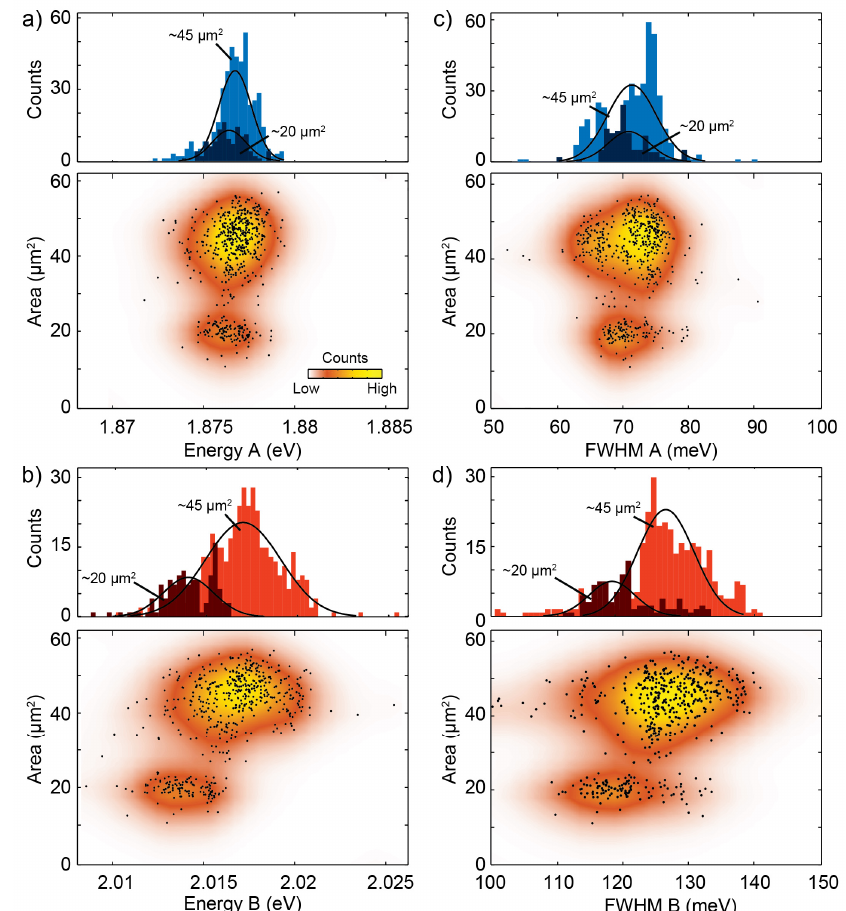
Figure 5. ( a ) Density plot of the triangle orientation as a function of the A exciton energy. (top) Conditional histograms of the A exciton energy for triangles with area between 15 μ m 2 and 25 μ m 2 (light blue) and triangles with area between 35 μ m 2 and 55 μ m 2 (dark blue). ( b ) Same as panel (a) for exciton B. ( c ) Density plot of the triangle orientation as a function of the A exciton peak FWHM. (top) Conditional histograms of the A exciton peak FWHM for triangles with area between 15 μ m 2 and 25 μ m 2 (light blue) and triangles with area between 35 μ m 2 and 55 μ m 2 (dark blue). ( d ) Same as panel (c) for exciton B.